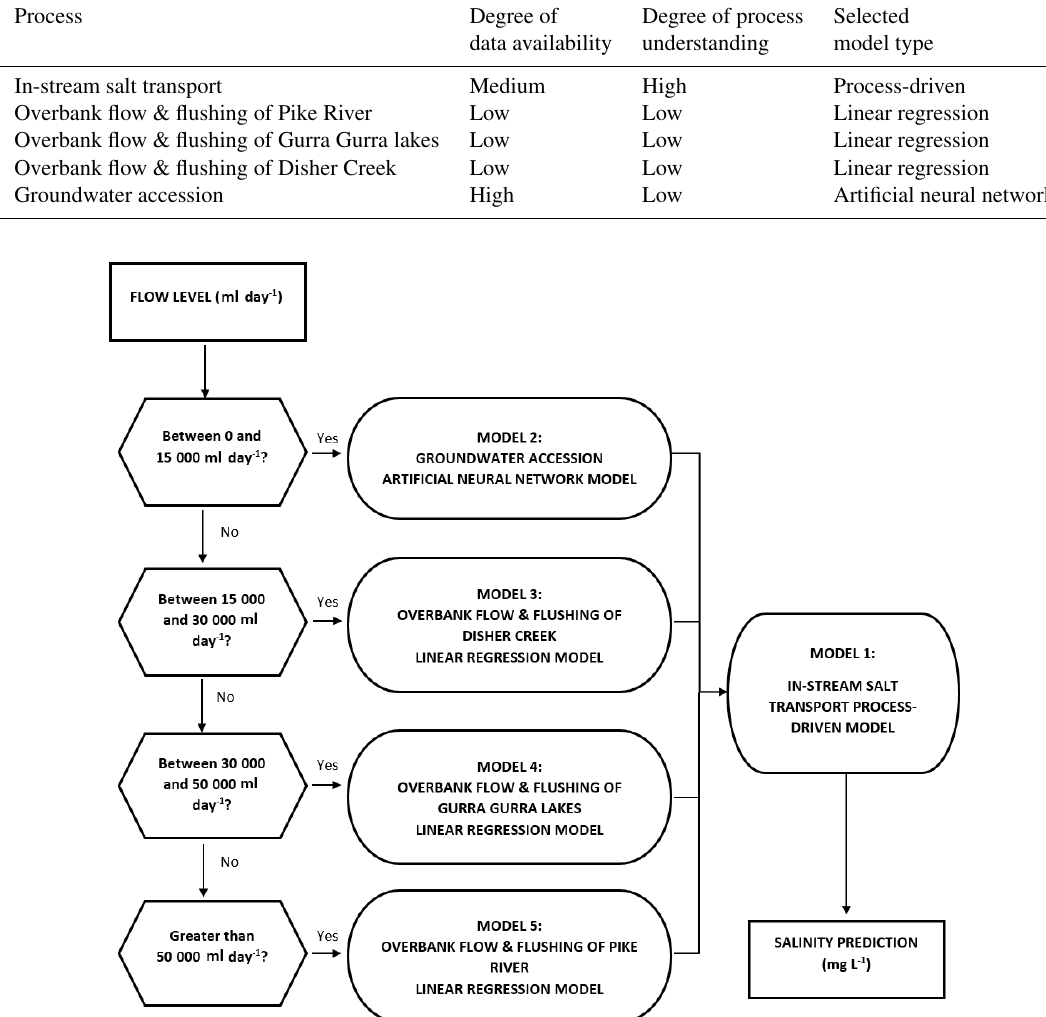
Figure 5. Conceptual representation of components of hybrid model and how they are